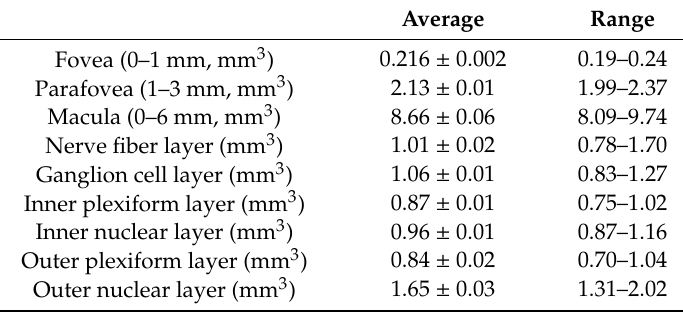
Table 2. Retinal neural volumes measured from optical coherence tomography images. Average